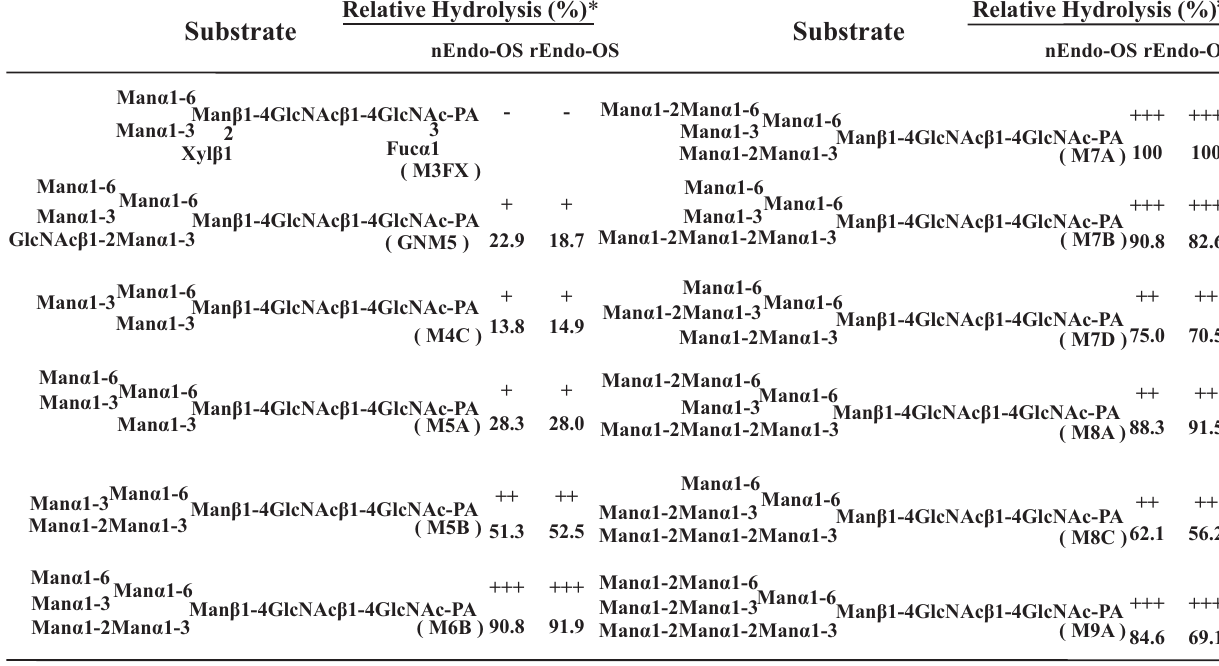
TABLE 3 | Comparison of substrate specificities of Endo-OS.